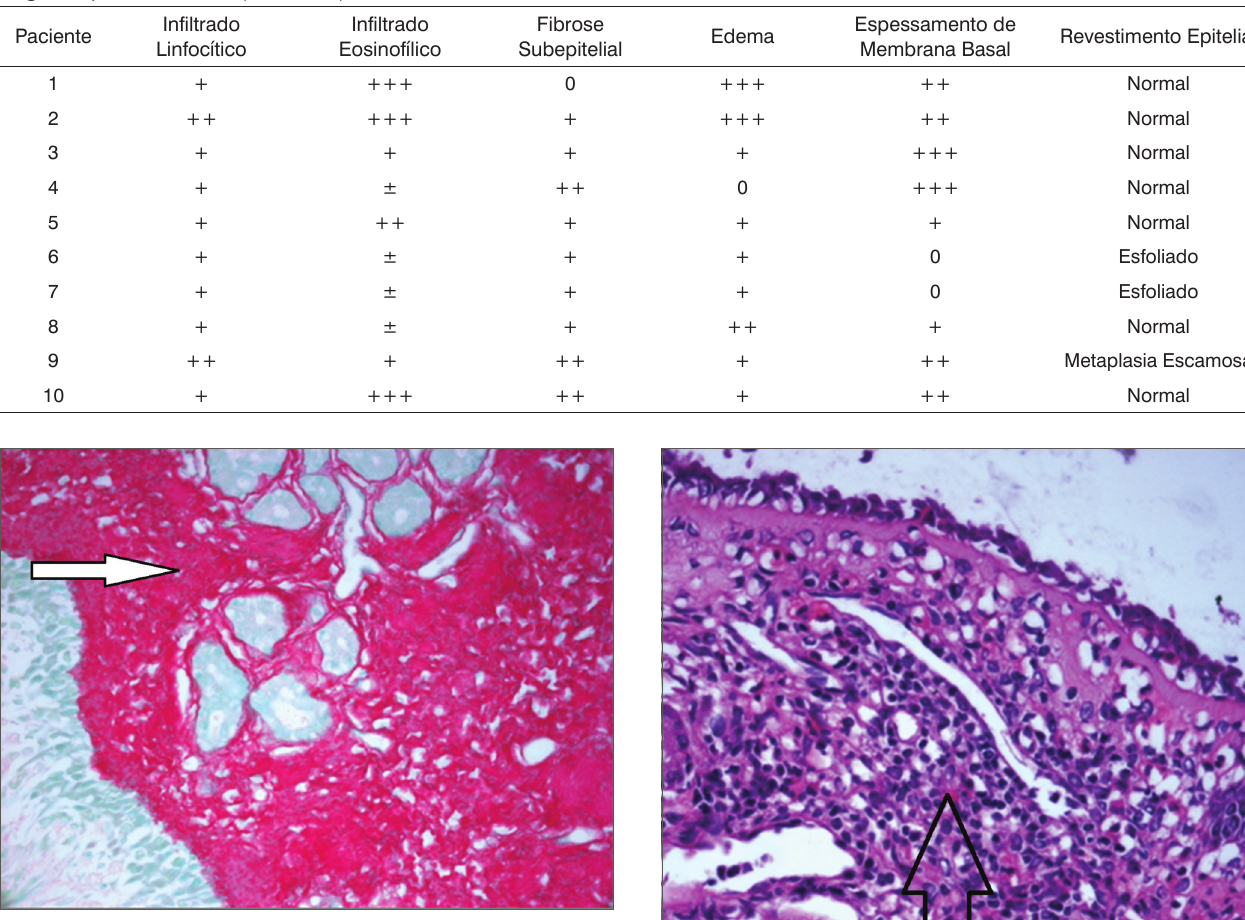
Figura 1. Fibrose subepitelial intensa na mucosa nasal de portador do HTLV-1 com rinite alérgica. Vermelho Sirius,